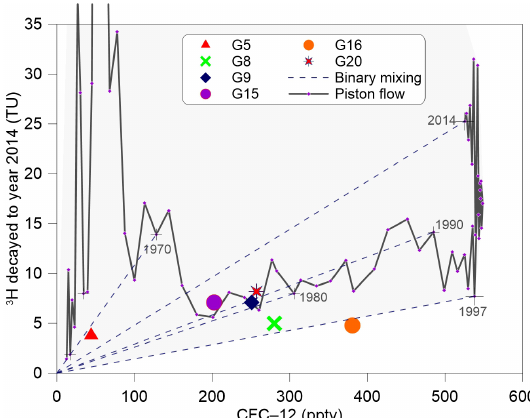
Figure 9. 3 H activity (TU) in Urumqi precipitation decayed to 2014 vs. CFC-12 in parts per trillion of volume (pptv) for Northern Hemi- sphere air. The “ + ” denotes selected calendar years. The solid lines correspond to the piston flow and the dashed lines show the binary mixing. The shaded region indicates concentrations that could arise due to mixing water of different